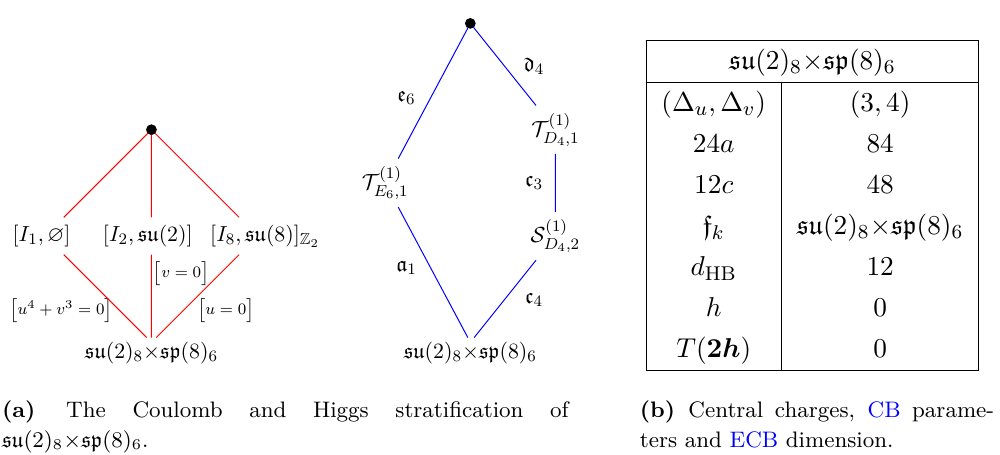
Figure 17. Information about the su (2) 8 × sp (8) 6